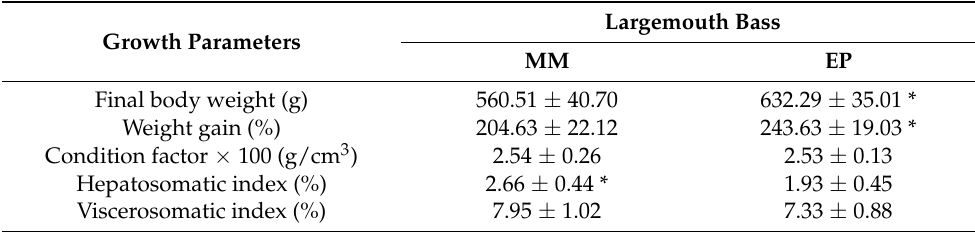
Table 3. Growth parameters of largemouth bass reared in the MM and EP groups from T1 to T3. Values are means ± SD ( n = 45).